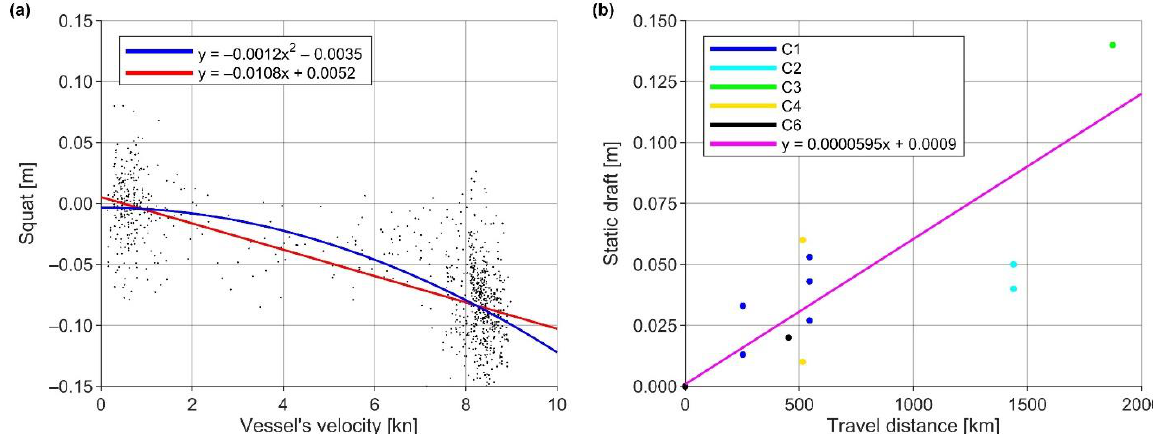
Figure 13. Empirically estimated ( a ) squat and ( b ) static draft corrections.